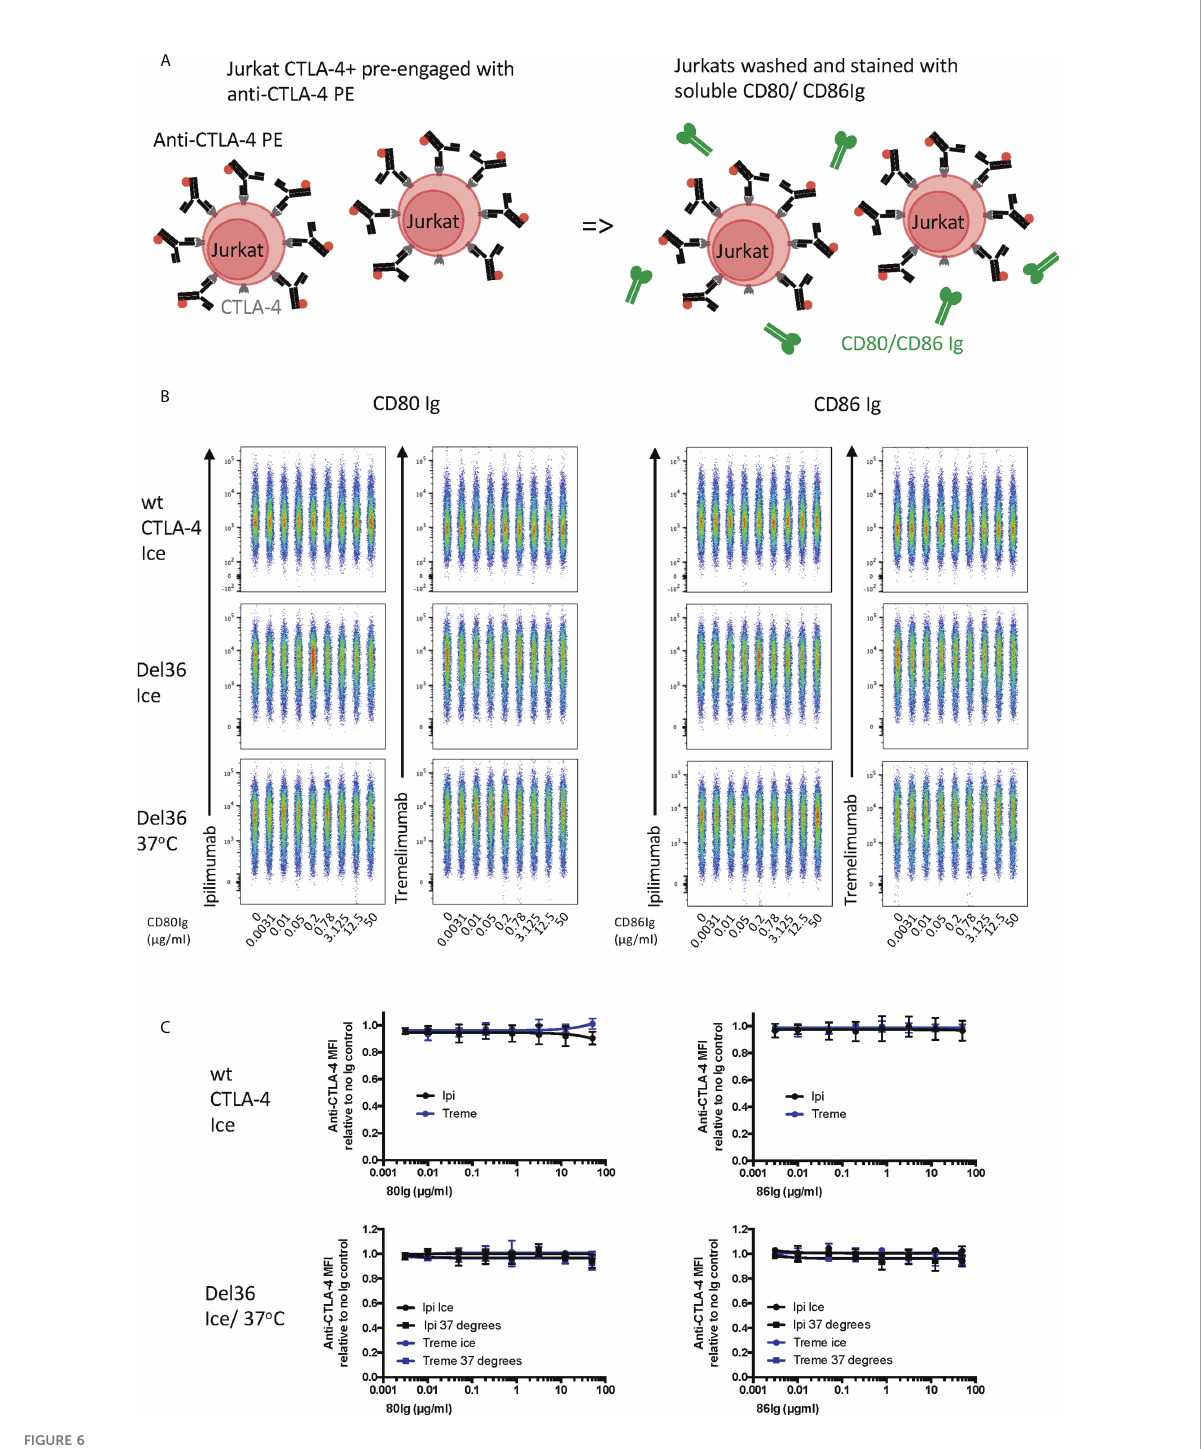
FIGURE 6 Soluble CD80 and CD86Ig are unable to displace pre-engaged Ipilimumab and Tremelimumab from cell bound CTLA-4. (A) Schematic of experimental set-up. Jurkat cells expressing CTLA-4 were pre-treated with a fi xed dose (2µg/ml) of soluble PE conjugated anti-CTLA-4 Abs on ice to pre-engage anti-CTLA-4-CTLA-4. Cells were washed and a titration of either soluble CD80 or CD86Ig was added. Cells expressing WT CTLA-4 were incubated on ice and cells expressing a non-internalising CTLA-4 mutant (Del 36) were incubated at either on ice or at 37°C. Cells were washed and analysed for anti-CTLA-4-CTLA-4 staining by fl ow cytometry. (B) Concatenated FACS plots showinganti-CTLA-4 binding at various doses of CD80 or CD86Ig (C) Dose response curves for ipilimumab (Black line) and tremelimumab (Blue line) presented as MFI anti- CTLA-4 binding from data in (B) Data for ipilimumab and tremelimumab were acquired in separate 96-well plates